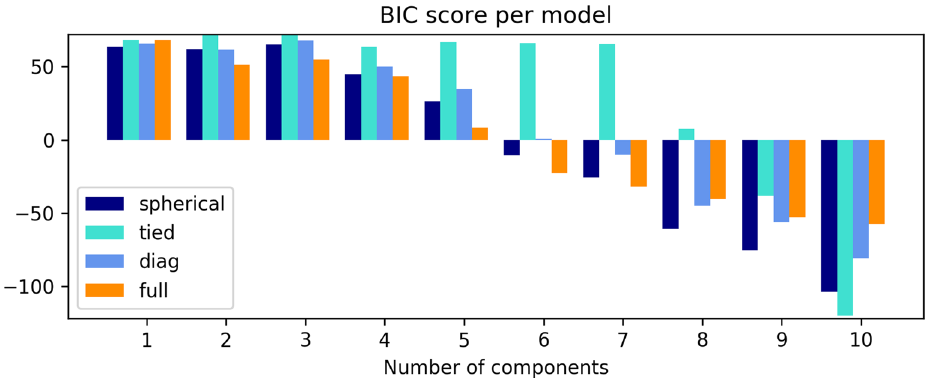
Figure 6. BIC score for various numbers of Gaussian components in GMM for data of FTIR